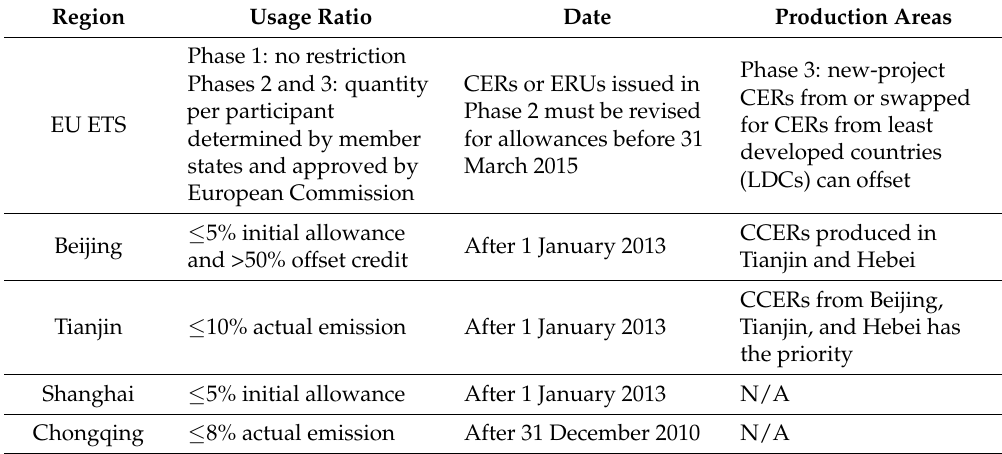
Table 8. Carbon offset restriction conditions in EU ETS and China’s pilot